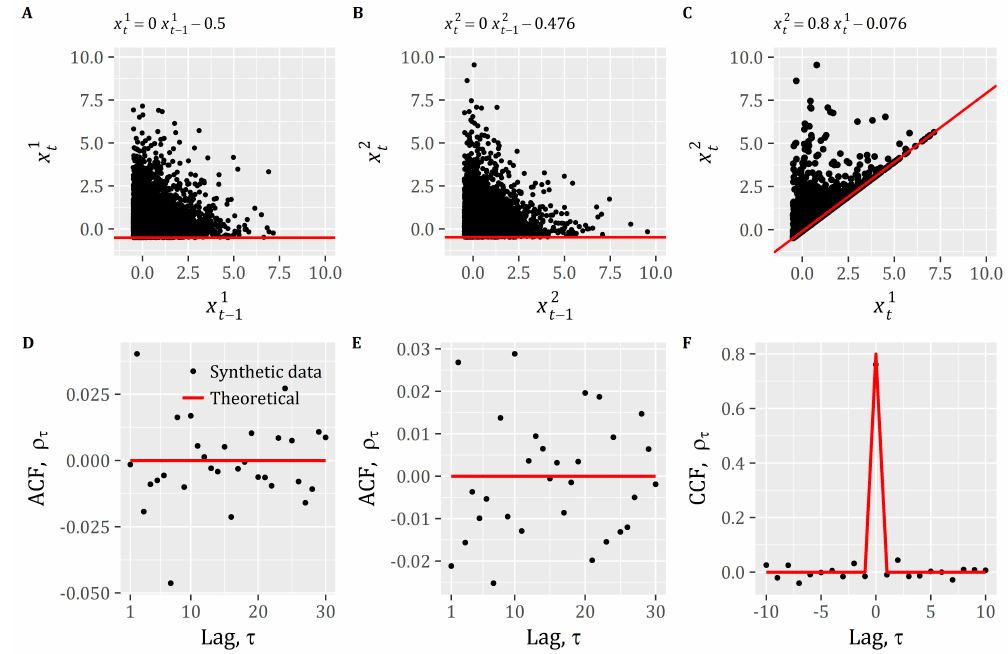
Figure 4. Scatter plots depicting the simulated (using the contemporaneous multivariate autoregressive model of order 1 (CMAR(1) model) with P III white noise) for ( A ) and ( B ) lag-1 dependence patterns of the zero-autocorrelated processes x 1 and x 2 , respectively, for consecutive time steps (i.e., pair values ( • ) of the previous and current time steps). Panel ( C ) depicts the contemporaneous dependence (lag-0) of x 1 and x 2 . The red line (—) depicts the envelope equation shown in the title of each plot. Panel ( D ) compares the simulated and theoretical autocorrelation function (ACF) of x 1 while panel ( E ) compares that of x 2 . Finally, panel ( F ) compares the simulated and theoretical cross-correlation function (CCF) of x 1 and x 2